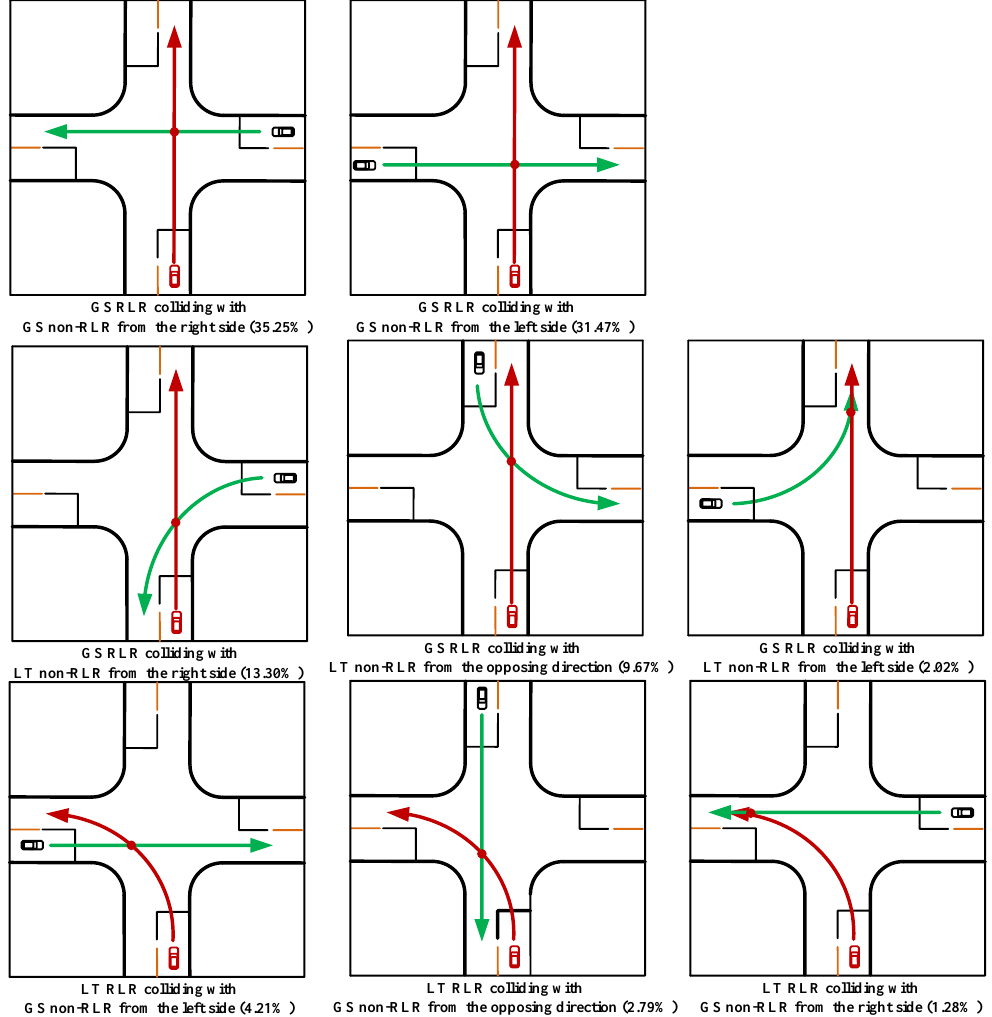
Figure 2. RLR collision scenarios for the three crash types. Note: the green line indicates the approaching path of non-RLR vehicle; the red line indicates the approaching path of RLR vehicle. GS represents vehicle’s go straight movement and LT represents vehicle’s left-turning movement.